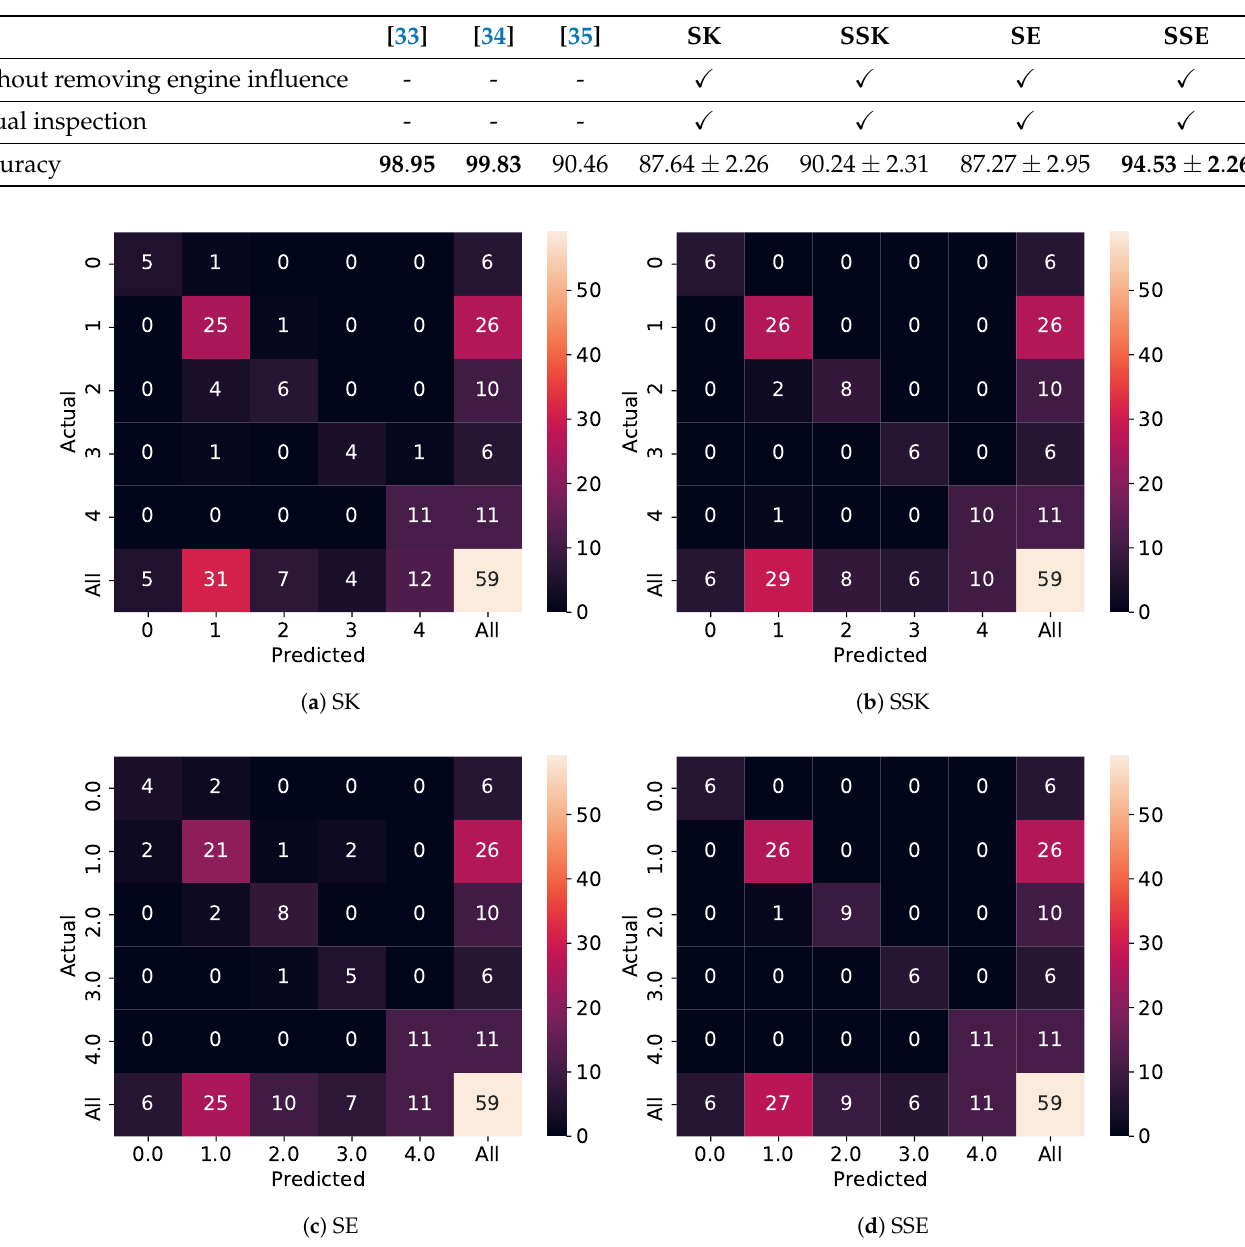
Figure 8. Confusion matrix of classification stage in CWRU dataset using SK, SSK, SE, and